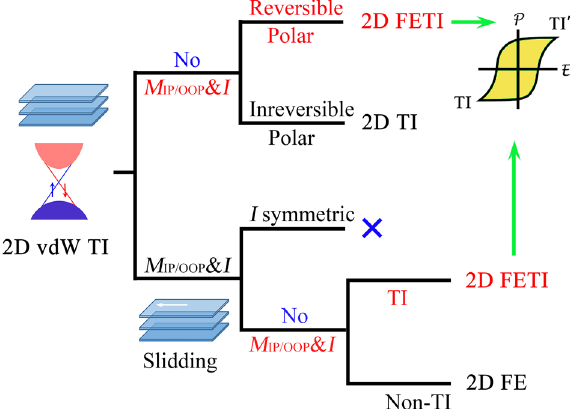
Fig. 1 Schematic diagram for screening 2D FETI. Schematic diagram for designing 2D FETIs from 2D van der Waals multilayers with nontrivial topological properties. Both topological and ferro- electric phases are determined by the mirror and inversion symmetry ( M IP/OOP & I ) of multilayer. Blue cross denotes the situation that is not under